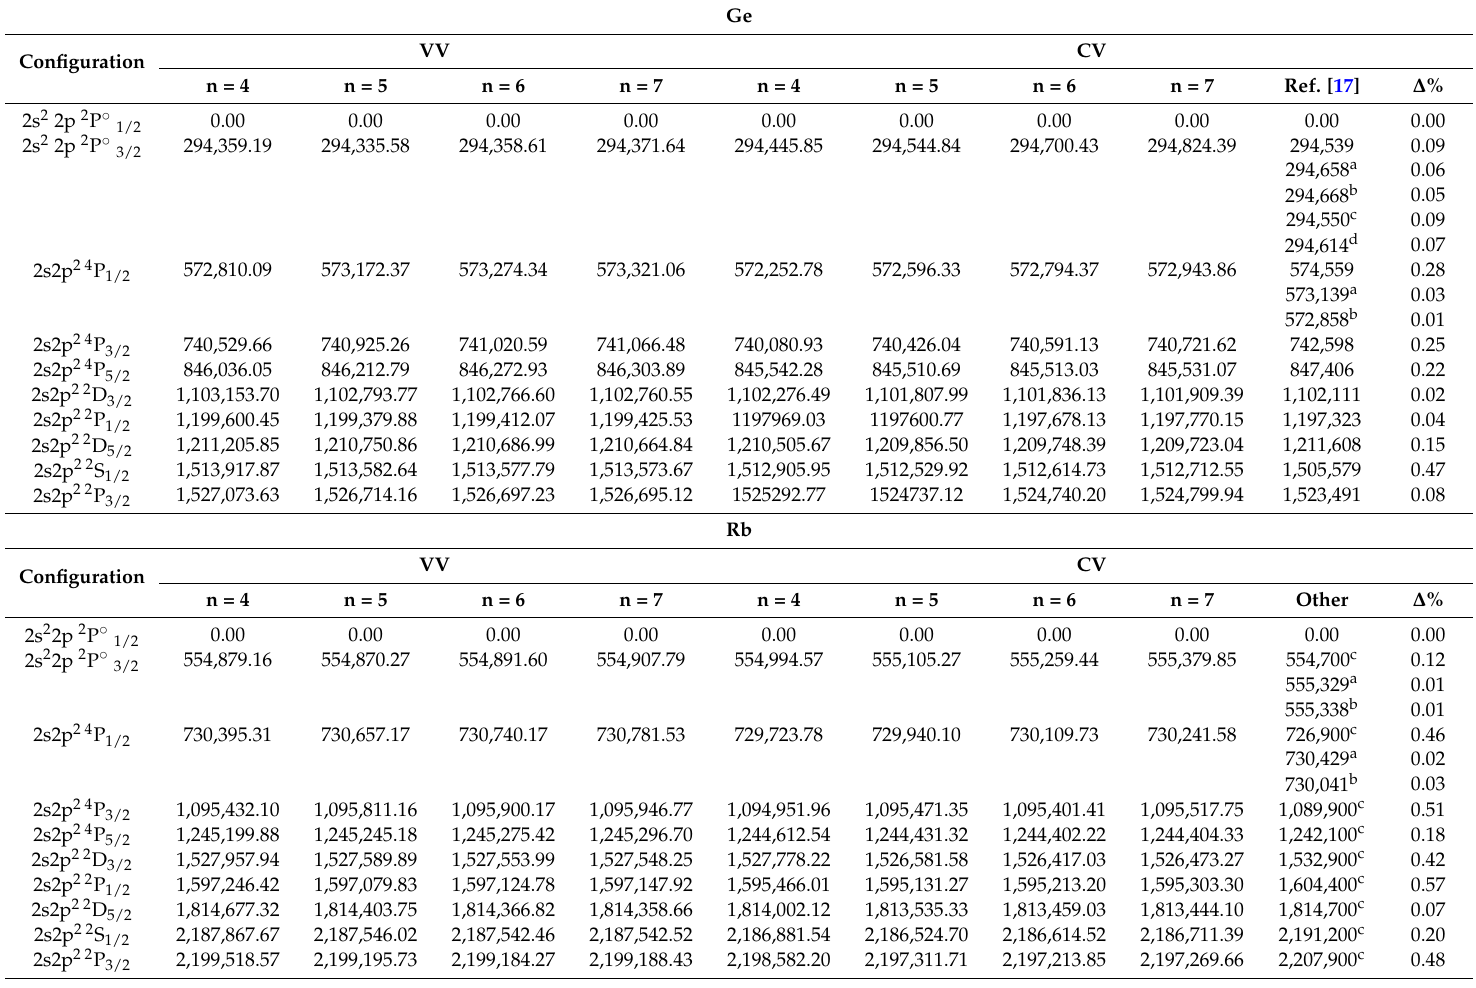
Table 1. Energies (in cm ´ 1 ) of fine-structure relativistic levels of Ge XXVIII, Rb XXXIII, Sr XXXIV, Ru XL, Sn XLVI, and Ba LII relative to ground state of B-like ions.